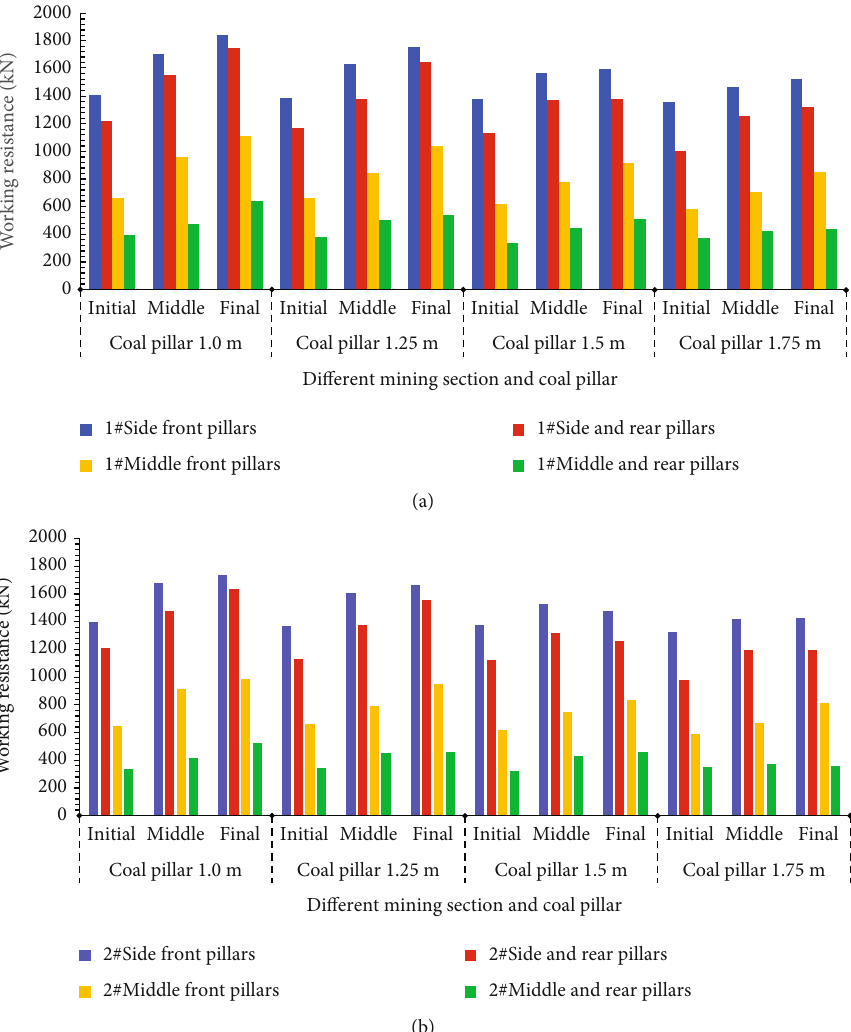
Figure 5: Simulation of maximum working resistance distribution of two PP supports under di ff erent coal pillars between mining caves and in di ff erent mining stages; (a) 1# support working resistance; (b) 2# support working